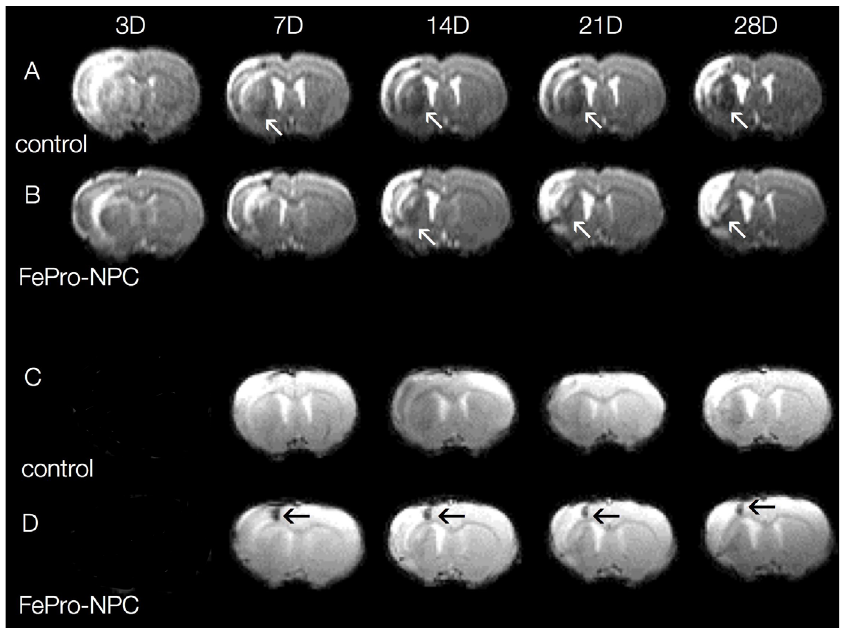
Figure 4. In vivo MRI. A , B , Serial T -weighted imaging up to 28 days post-ischaemia in FePro-NPC and control animals. Regions of T 2 hypointensity develop in the lesion at later timepoints (white arrows). C , D , Serial T *-weighted imaging up to 28 days post-ischaemia in FePro- 2 NPC and control animals. The injection site of FePro-labelled cells can be identified in the FePro-NPC group at all timepoints (black arrows).